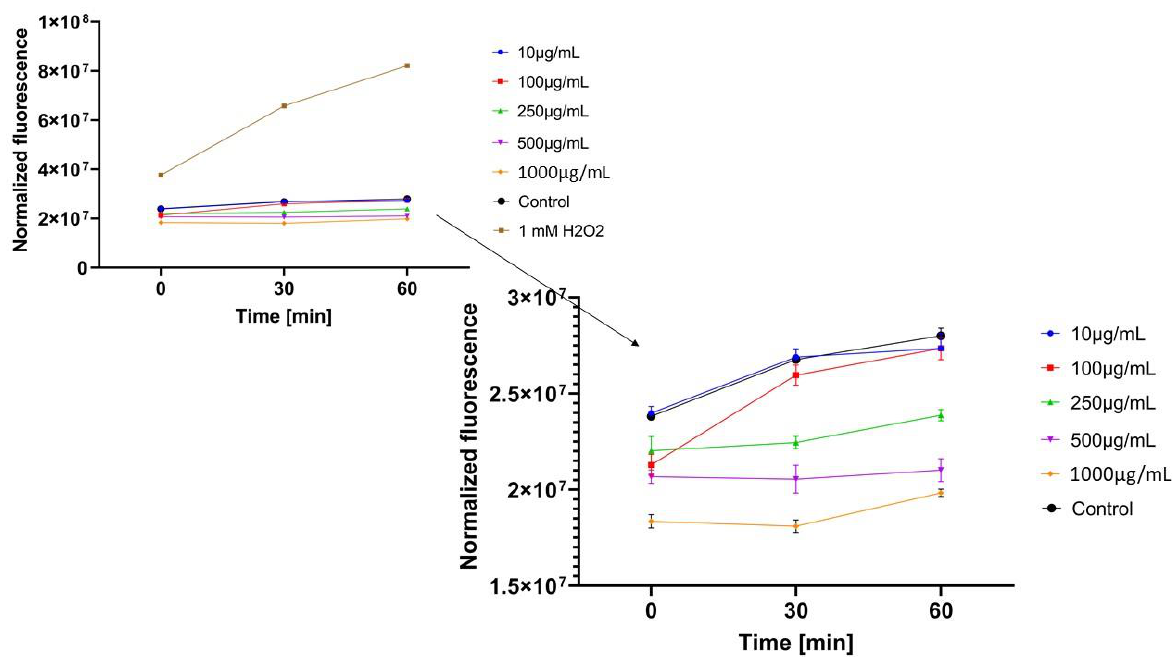
Figure 4. The effect of Centella asiatica L. extract on the 2’,7’-dichlorofluorescein (DCF) fluorescence in keratinocyte cells HaCaT. The data are expressed as the mean ± SD of 3 independent experiments, each of which consisted of 3 replicates per treatment group.